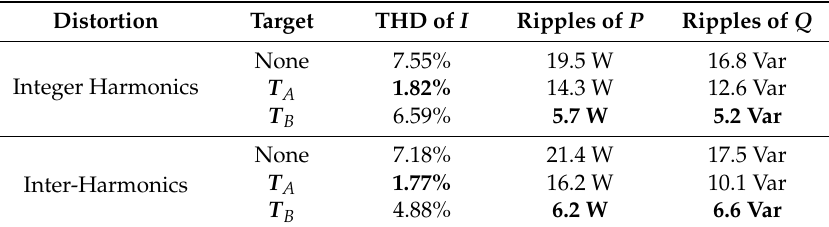
Table 1. Contrastive analysis of the experimental